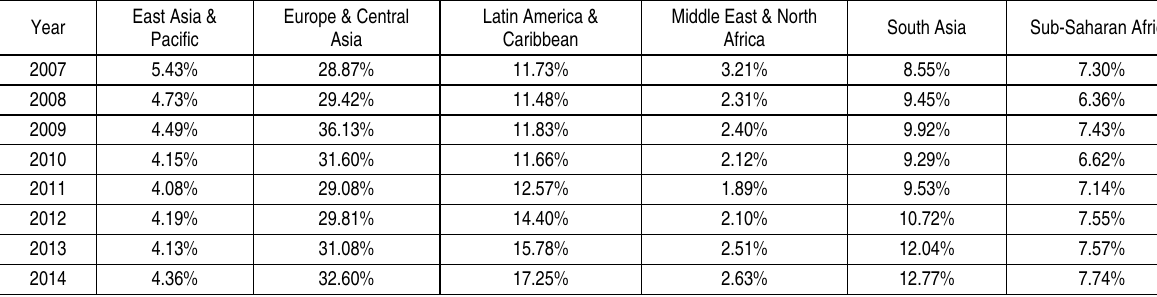
Table 9 (cont.). Trends in VR external debt to GDP region-wise